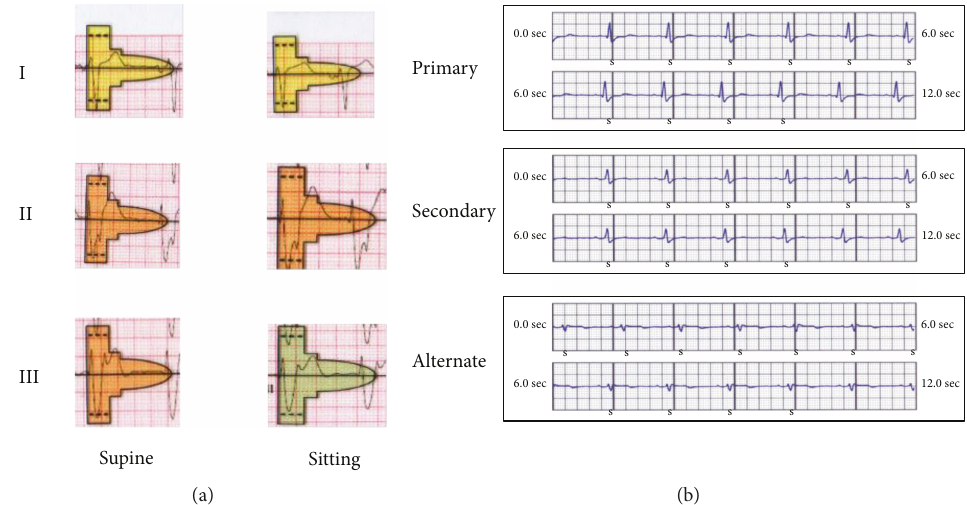
Figure 4: (a) Manual ECG screening test showing only lead I (alternate vector) in supine and sitting positions as acceptable vector at 10mm/mV. (b) Postimplantation S-ECG sensing with gain setting 1X showing adequate sensing in the primary, secondary, and alternate vectors. The primary vector was automatically selected. S: subcutaneous.